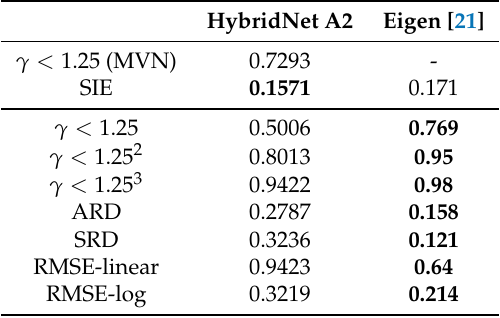
Table 8. Depth estimation results on NYU V2 Quantitative evaluation: PP, PP-MVN, ARD, SRD, RMSE-linear, RMSE-log, and SIE (best results in